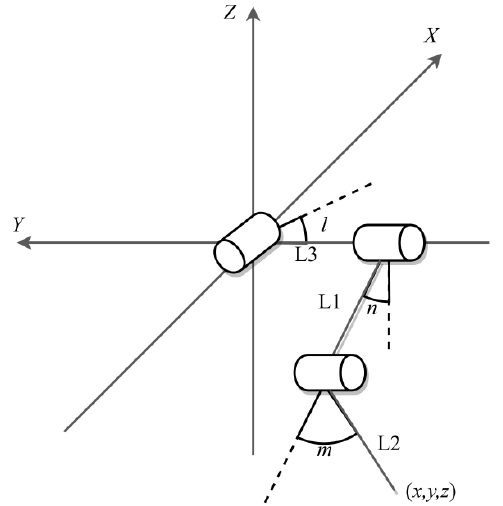
Figure 7. The position of the right front leg of a quadruped robot in the coordinate system, where 𝑚, 𝑛, 𝑙 are the three joint rotation angles of the robot, and 𝐿1, 𝐿2, 𝐿3 are the shoulder joint length, thigh length, and calf length of the robot, respectively.